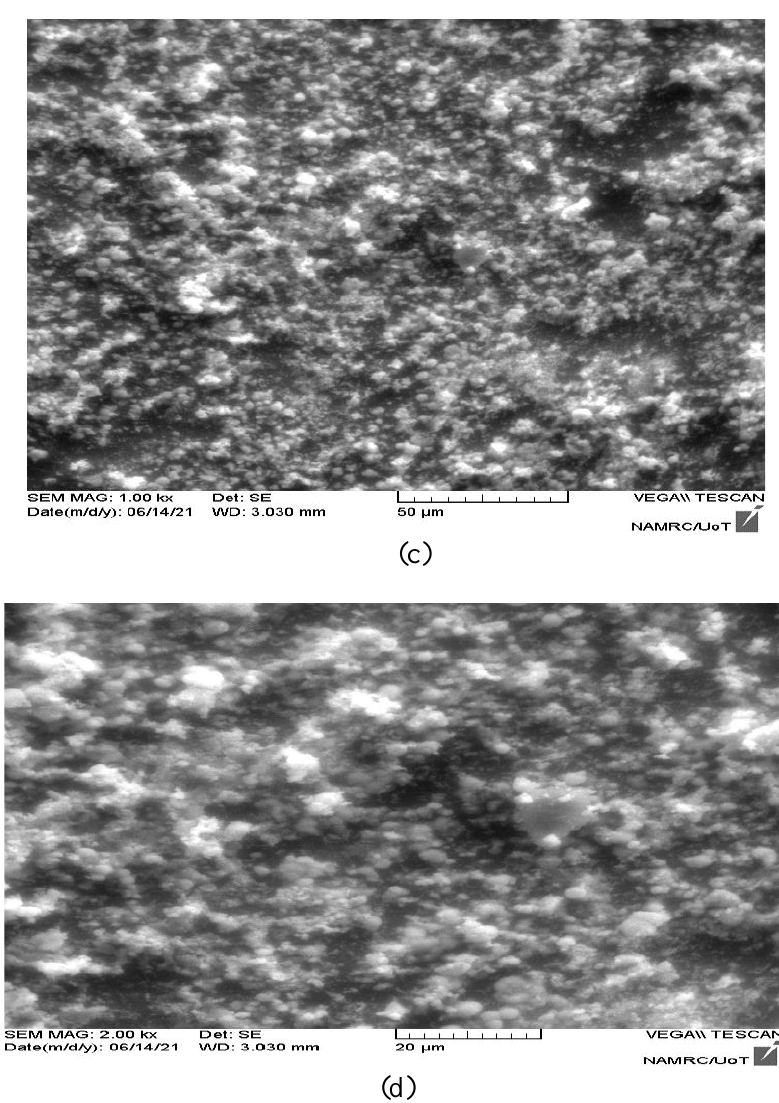
Figure 3 (c, d): SEM image of 0.2 gm/cm 3 of CdO thin film for